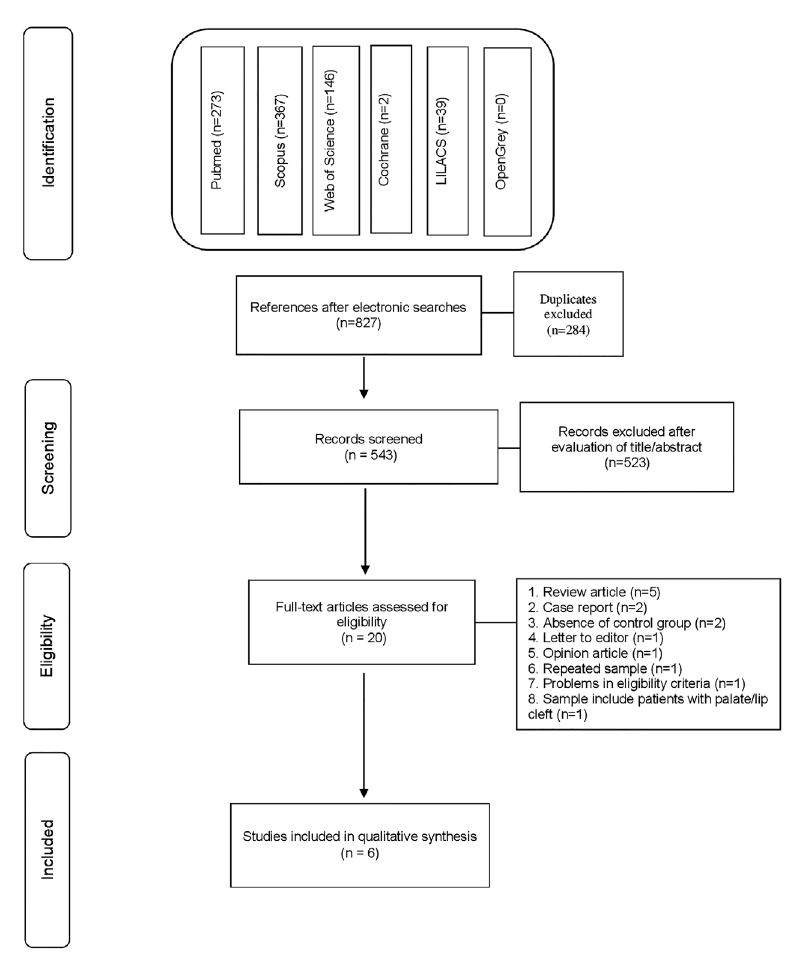
Figure 3- Flowchart with number of records at each stage of the review according to PRISMA